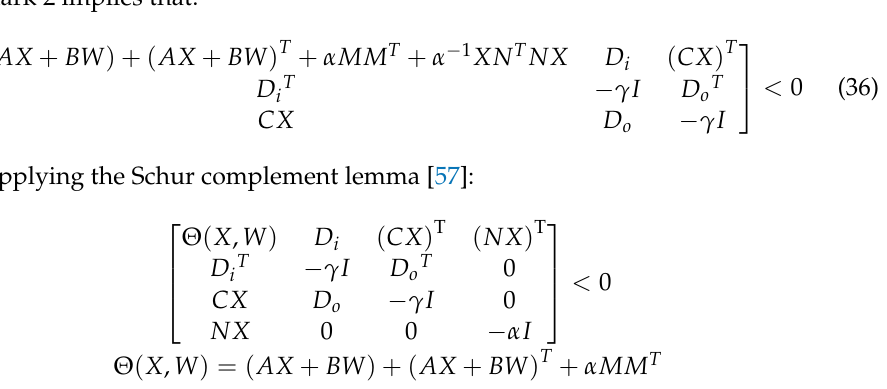
Figure 2. Two ‐ dimensional graphic of a ball and beam system Microsoft Visio ® , Pro 2019 v2005 Build 14026.20302 Retail.